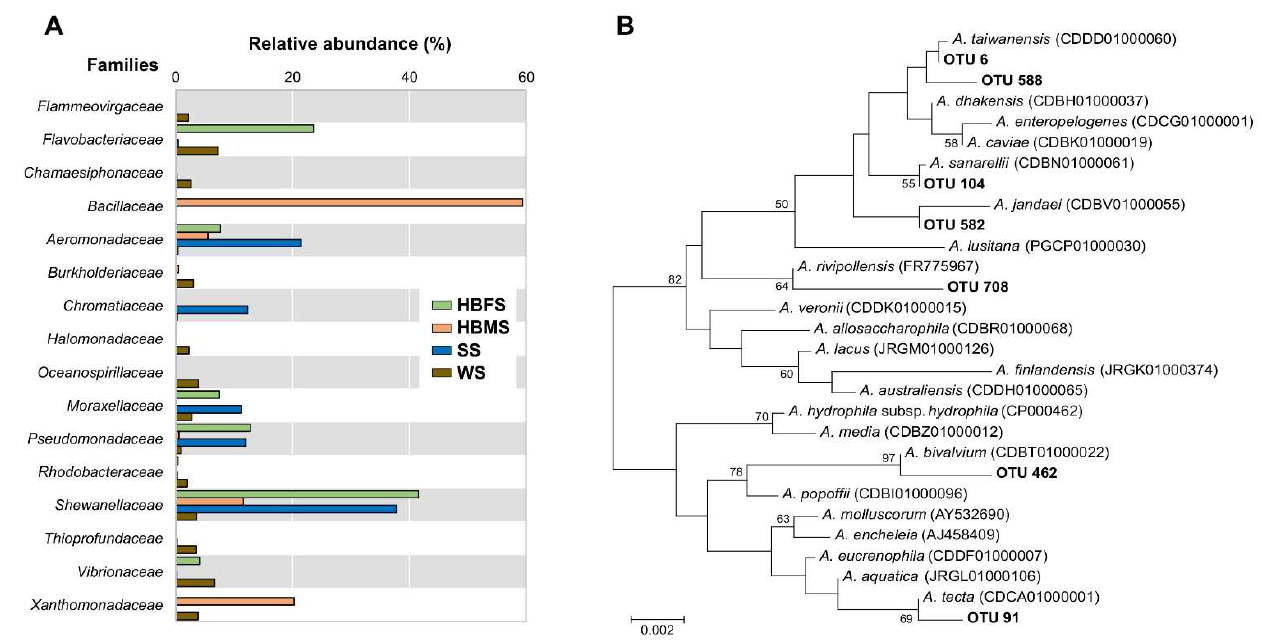
Figure 1. ( A ) Relative abundance of dominant bacterial families found in the skin samples from Barbour’s seahorses as well as in water and sediment samples from the surrounding environment. ( B ) Phylogenetic dendrogram of selected OTUs with the most closely related Aeromonas species based on 16S rRNA gene sequences (420 bp) and constructed by the neighbor-joining method. Bootstrap percentages (>50 %) based on 1000 replications are shown at branch nodes. Bar, 0.002 estimated substitutions per site.